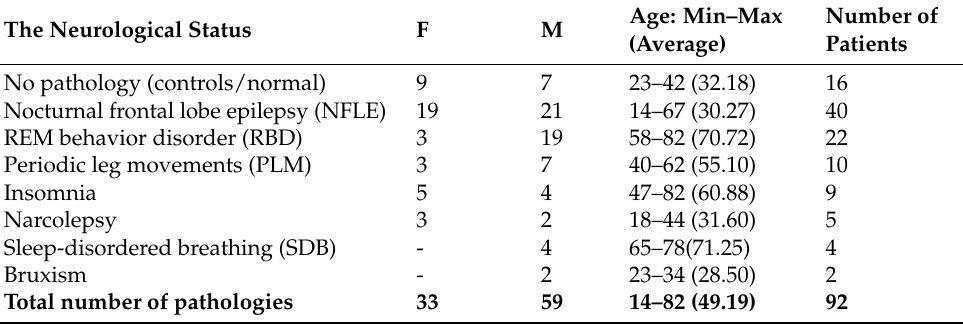
Table 2. Neurological status and number of